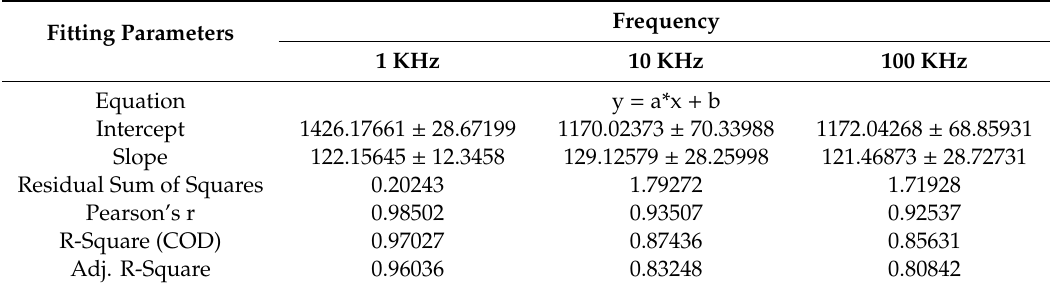
Figure 11. ( a ) Extracted results from the mean impedance magnitude values for di ff erent concentrations of AFB 1 spiked pistachio samples at 100 KHz ± STD. Di ff erent letters (a, b, c, d, e) indicate statistically significant di ff erent values ( p < 0.05). ( b ) Linear fit curve of the normalized values of the mean impedance magnitude for concentrations of AFB 1 spiked pistachio samples (1–100 ng / mL) tested at 100 KHz. Table 2. Fitting parameters from the linear fit curve of the normalized values of the mean impedance magnitude for concentrations of AFB 1 spiked pistachio samples (1–100 ng / mL) tested at three di ff erent frequencies (1 KHz, 10 KHz, 100 KHz).